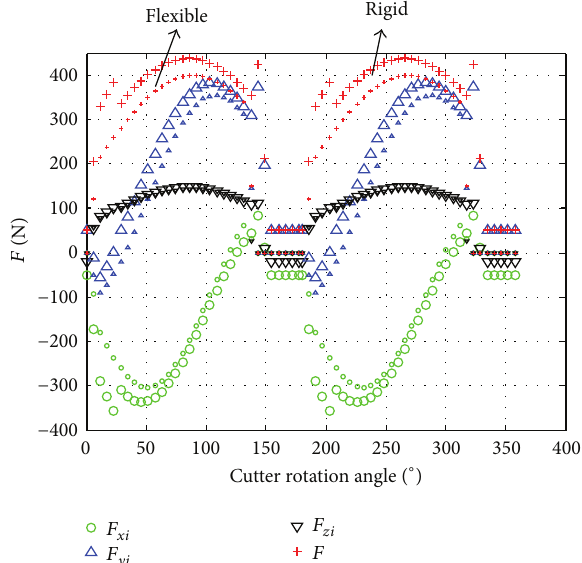
Figure17:Comparisonsofcuttingforcesinflexibleandrigidmodel.